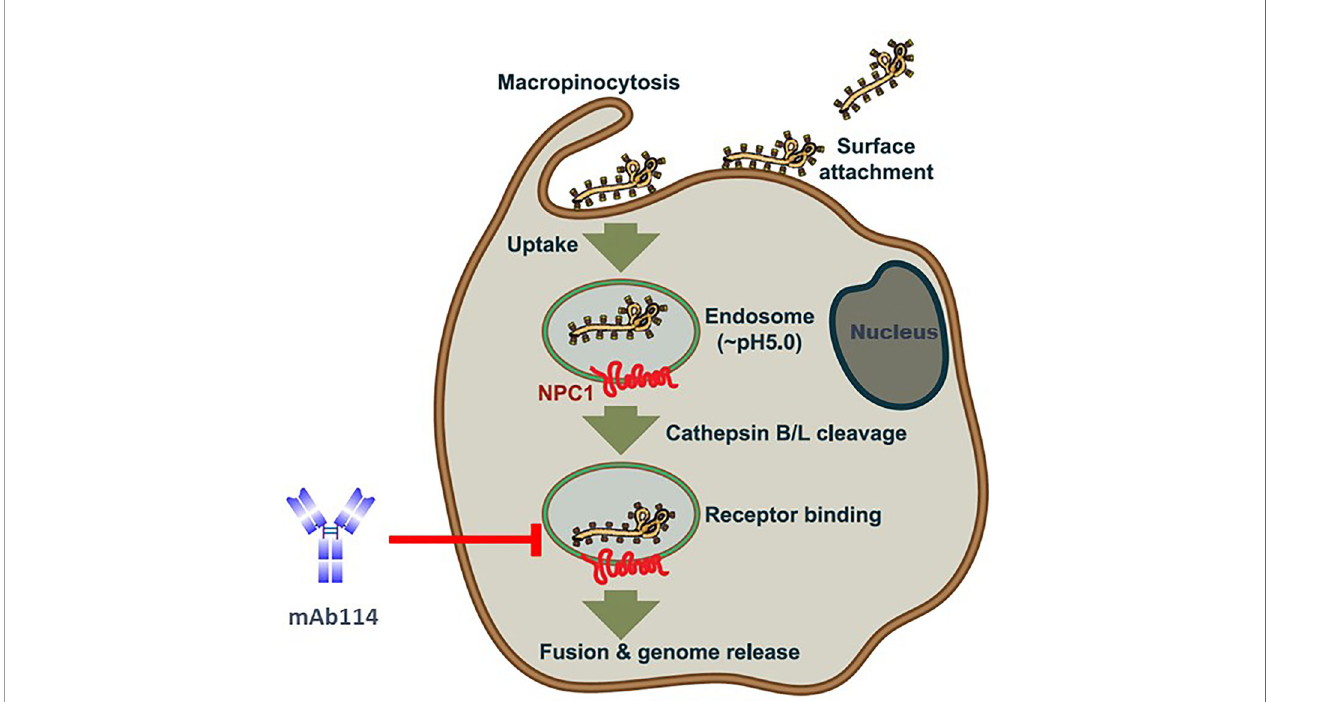
FIGURE 3 | Ebola virus uptake, entry model, and mAb114 mode of action [(adapted from ref (21). Viral particles bind to various surface factors and trigger macropinocytosis, leading to traf fi cking to endosomes. Acid-dependent proteases (cathepsin B and cathepsin L) remove the MLD and glycan cap in the low-pH endosome environment, revealing the RBD in the GP1 core, previously blocked by these domains. The host cell receptor, NPC1(red), is then engaged by virions with exposed RBDs, resulting in the host and viral cell membranes fusion and the release of the viral genome into the target cell cytoplasm. In late endosomes, mAb114 binding prevents the GP from interacting with the host cell receptor protein NPC1. Brown shading indicates the cell membrane and cytoplasm. The endosomal membrane is green with a brown border, while the endosomal lumen is light gray. The nucleus is dark gray, with a blue-black membrane around it.